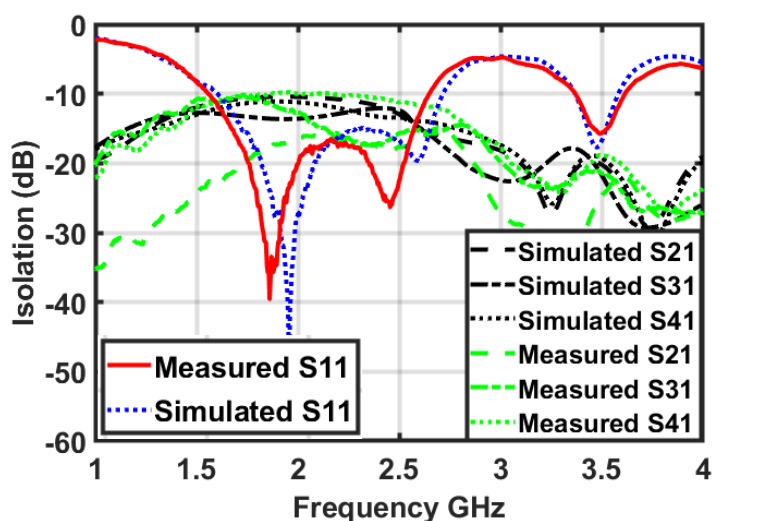
Figure 7. Simulated and measured S-parameters of the dual-band MIMO antenna